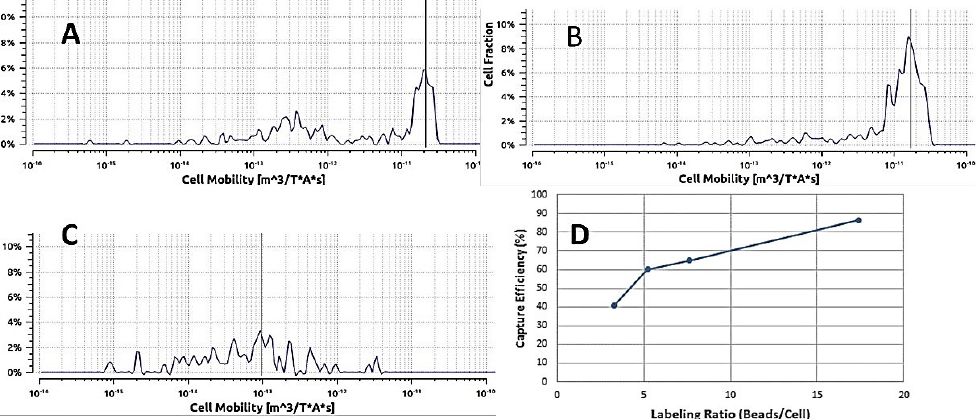
Figure 7. Results of tumor cell capturing experiments. ( A ): Magnetophoretic mobility histogram of starting population of chicken lymphoma cells pre-labeled with Dynabeads showing broad distribution of unlabeled cells and high-mobility peak at 20 × 10 − 12 m 3 /TAs of fully labeled cells. ( B ): Mobility histogram of trapped cells showing nearly complete depletion of unlabeled cells. ( C ): Mobility histogram of untrapped cells collected at the outlet consisting of only unlabeled cells and showing complete depletion of labeled cells. ( D ): Effect of labeling ratio on the efficiency of capture. All labeled cells are captured, and unlabeled cells are not.